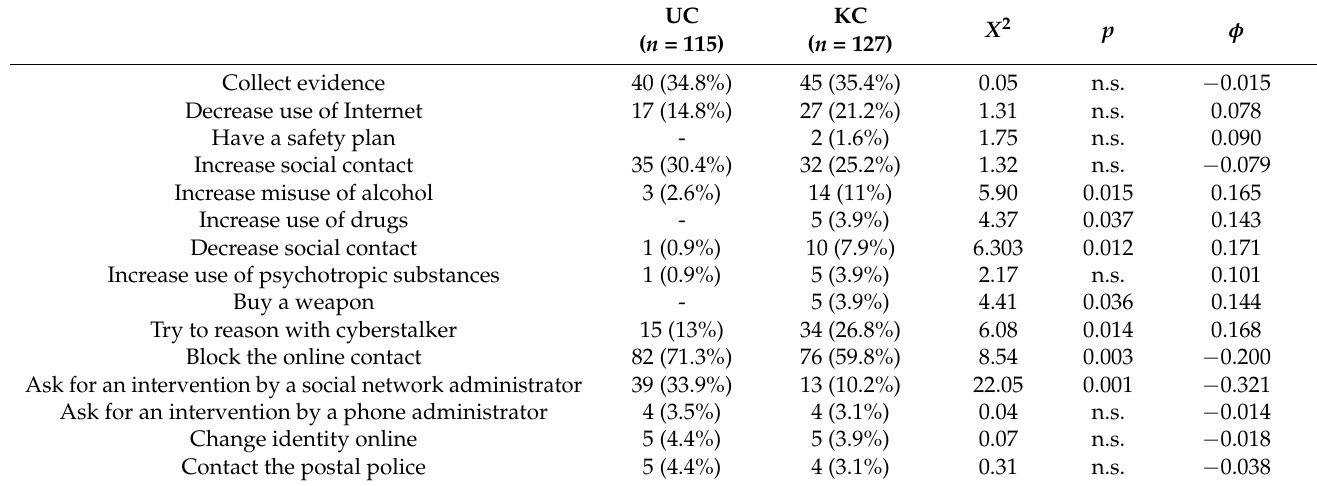
Table 5. Coping strategies: comparison between victims of UC and KC (percentage in brackets). UC ( n =